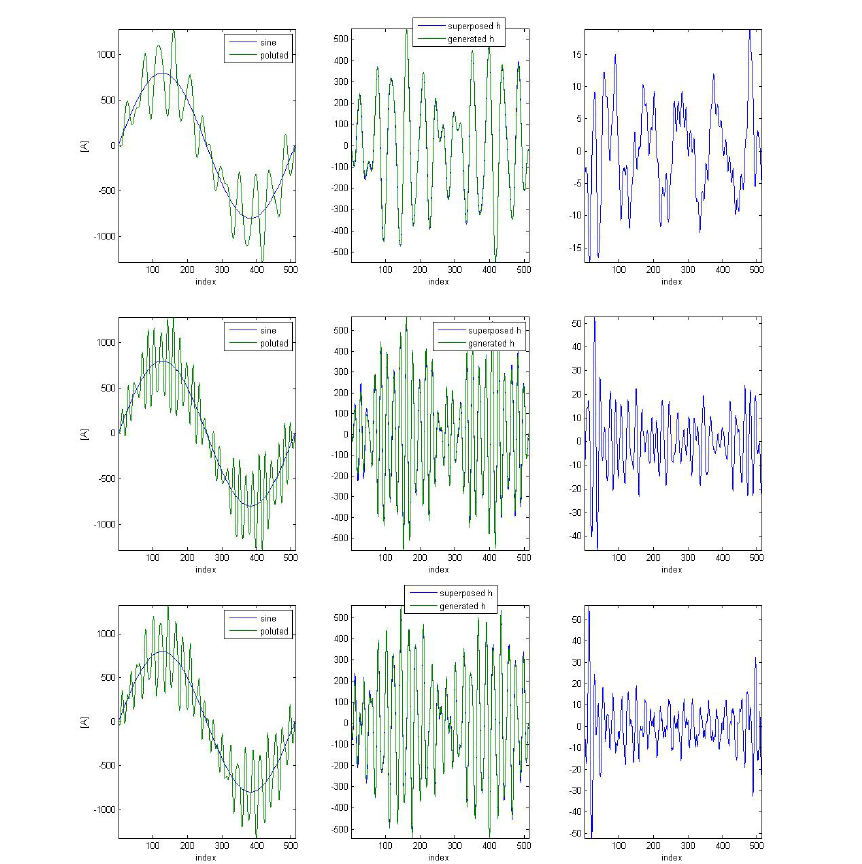
Figure 4. Results of decompositions / recompositions yielded by the optimized algorithm for synthetic signals. From top to bottom, 5-th CN7, 6-th CN7 and 7-th CN7. From left to right : perfect sinusoid overlapped with the signal composed from the superposition of the harmonics associated to the cluster, middle – generated and harmonic content reconstructed with WPT, right – di ff erence between the gen- erated and reconstructed harmonic